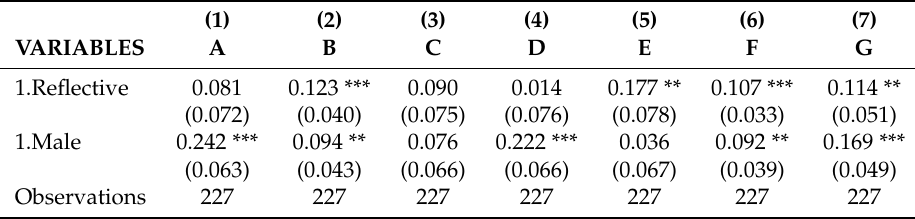
Table A6. Marginal effects from Logistic regressions.